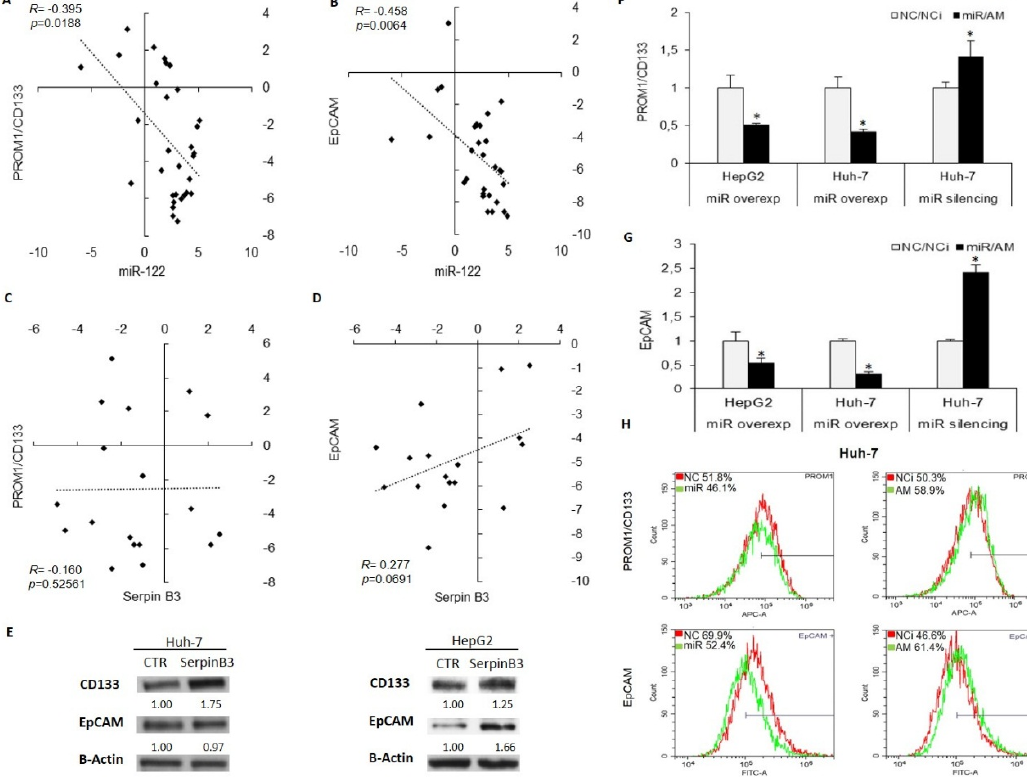
Figure 4. ( A ) Correlation graphs between tissue miR-122 and PROM1/CD133 or ( B ) SerpinB3. ( C ) Correlation graph between EpCAM/CD326 and SerpinB3 or (D) miR-122 levels in the same HCC patient cohort. The X- and Y-axes report 2 − ∆∆ Ct values from qPCR analysis converted in a log 2 form. U6RNA was used as housekeeping gene for miR-122 normalization, whereas β -Actin was used for gene normalization. ( E ) PROM1/CD133 and EpCAM protein detected by WB analysis in SerpinB3-overexpressing and empty vector-bearing (CTR) HCC cell lines. β -Actin was used as housekeeping gene. ( F ) PROM1/CD133 and ( G ) EpCAM mRNA levels in miR-122-overexpressing (miR) or silenced (AM) HCC cell lines. The Y-axis reports relative values with respect to negative controls. ( H ) Immunophenotype analysis of PROM1/CD133 and EpCAM levels in miR-122 (miR) or anti-miR-122 (AM)-transfected Huh-7 cells. The percentage of positive cells is reported on the top left of the histogram graph. NC: negative control precursor miRNA. NCi: negative control inhibitor miRNA.